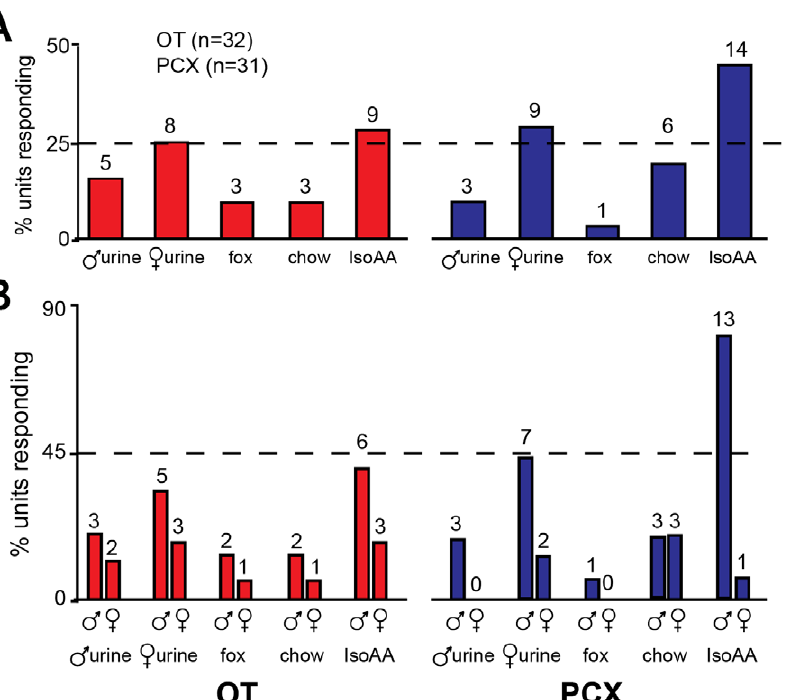
Figure 5. OT and PCX units show odor-specific and sexually-differentiated odor responsivity. Histogram of OT and PCX odor response data calculated in ‘% responding’ (as in Fig. 4A), with male and female subjects grouped ( A ) and sorted by sex ( B ). Numbers above bars= # units responding.